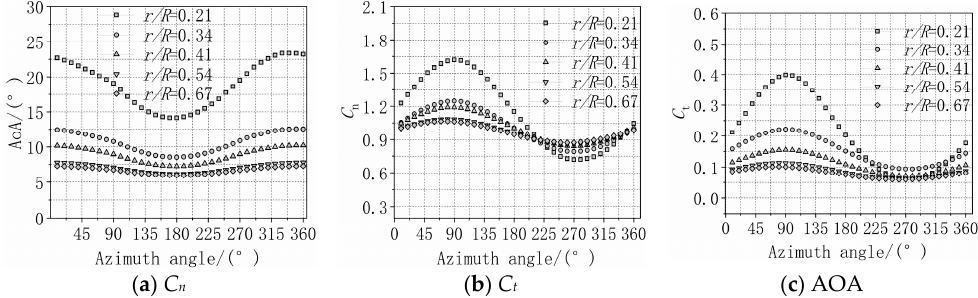
Figure 12. Azimuthal aerodynamic loads at different spanwise sections during one revolution under a yaw angle of 15°.